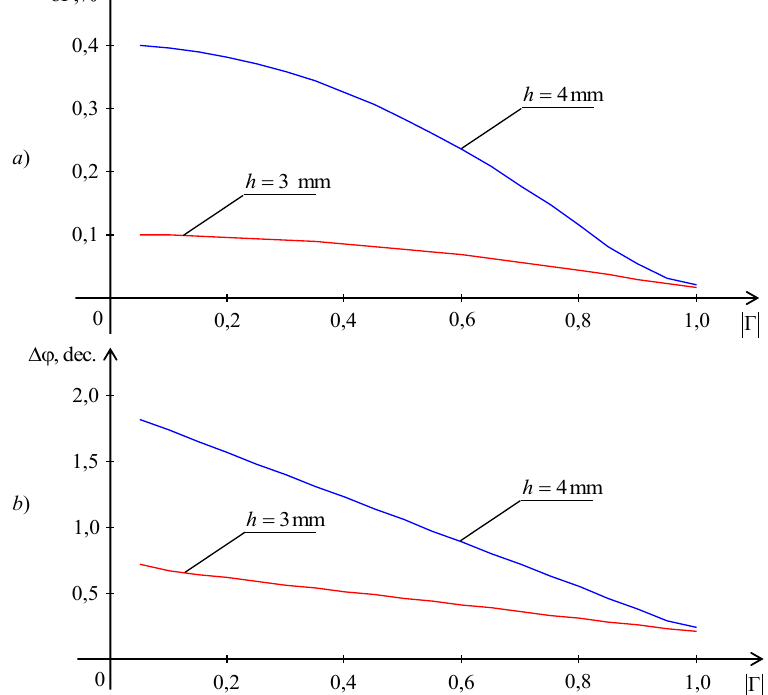
Fig. 3. Dependences of the measurement errors of the module and the CRC argument on the value of the